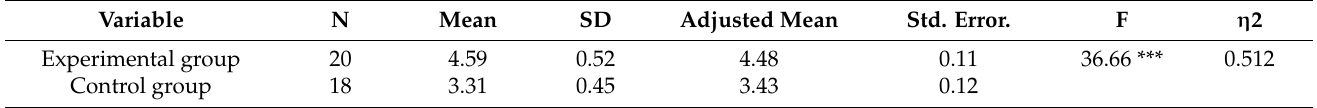
Table 3. ANCOVA self-efficacy analysis results for the experimental group and control